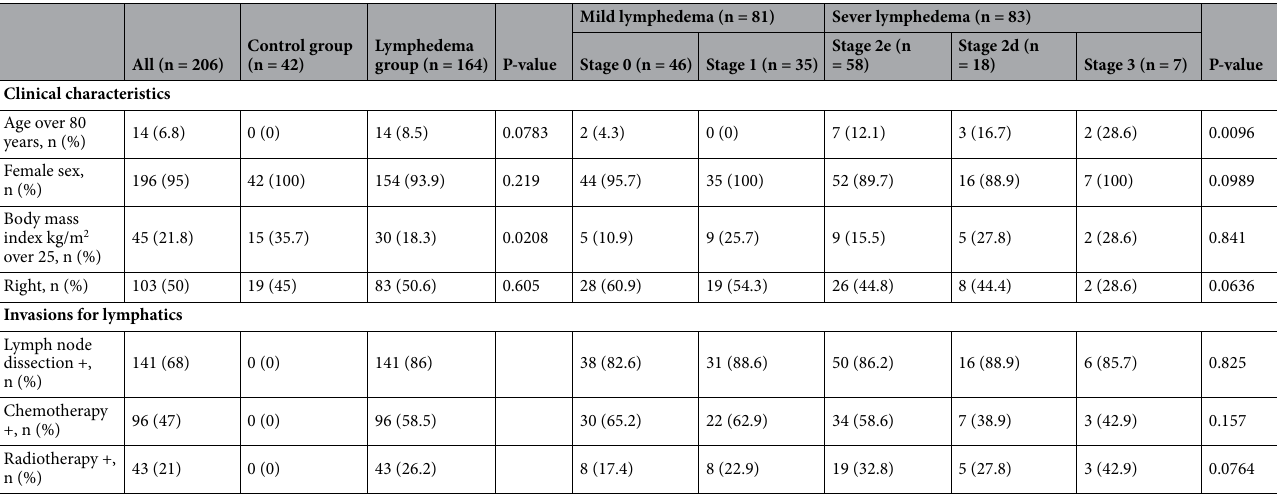
Table 1. Characteristics of patients in control, in lymphedema, in mild type, and in sever type.